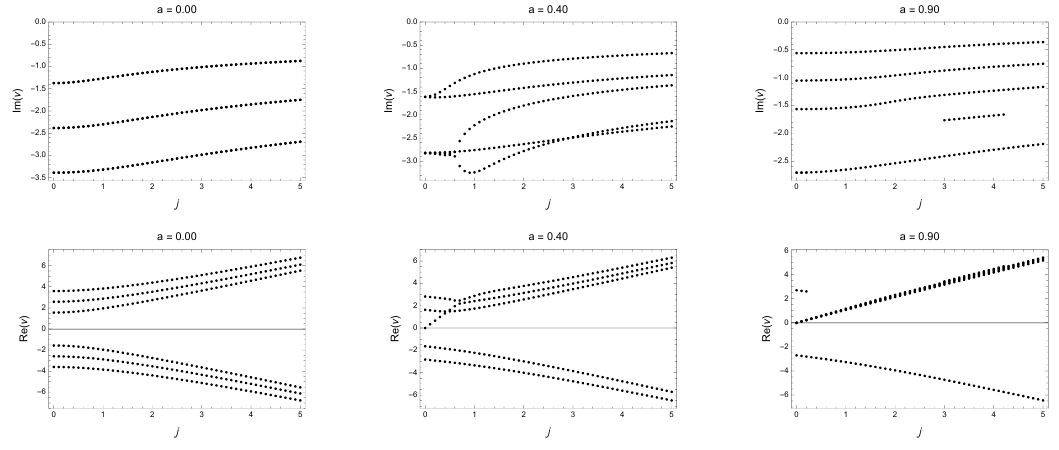
Figure 14 . Tensor sector dispersion relations. Displayed are the real (lower plots) and imaginary (upper plots) part of the QNM frequencies of the h ++ -perturbation around a large black hole as a function of the parameter j . This parameter is de(cid:12)ned for large black holes where ! ! (cid:11)(cid:23) and J ! (cid:11)j as (cid:11) ! 1 . Due to this limit on the level of the (cid:13)uctuation equation for h ++ , this is